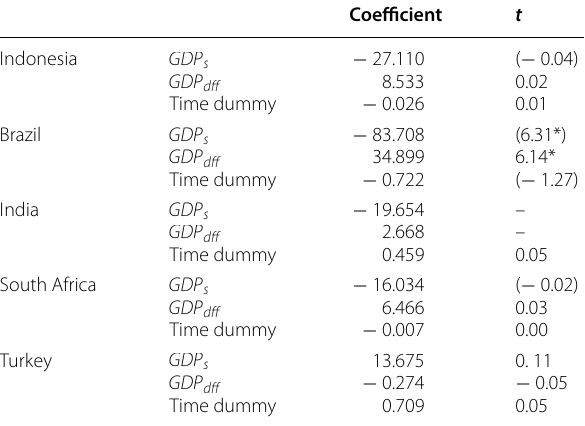
# - All the estimated results, which were small for India, did not generate. Due to their substantial and small values, a few S.E. and t‑Statistic values are not